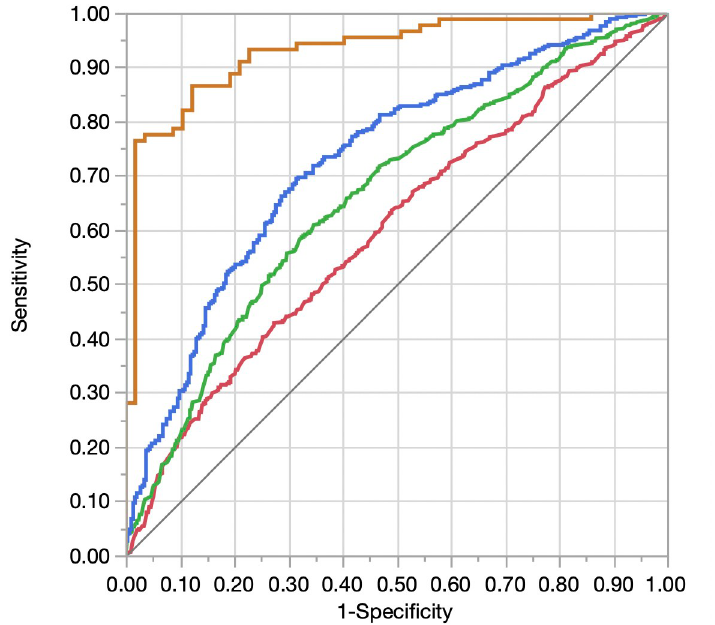
Fig 2. Receiver operator curve displaying differences in discrimination between adjusted models for heart failure readmission. Red = Model 1 (Demographics and Physiologic Variables); Green = Model 2 (Model 1 + Comorbidities); Blue = Model 3 (Model 2 + Echocardiographic Structural Variables); Orange = Model 4 (Model + Echocardiographic Diastolic Variables).